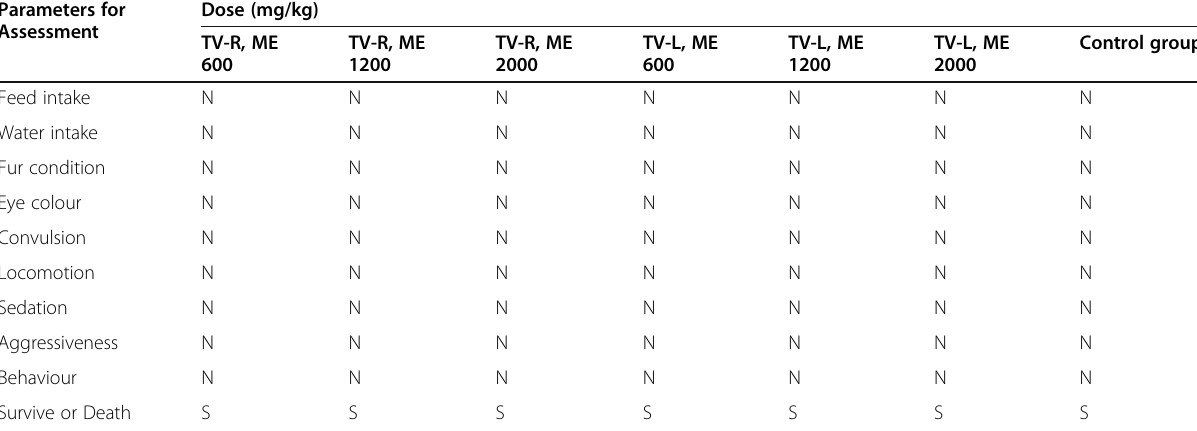
Table 2 Assessments during Sub-acute toxicity study, recorded observations from day 1 – 28 Parameters for